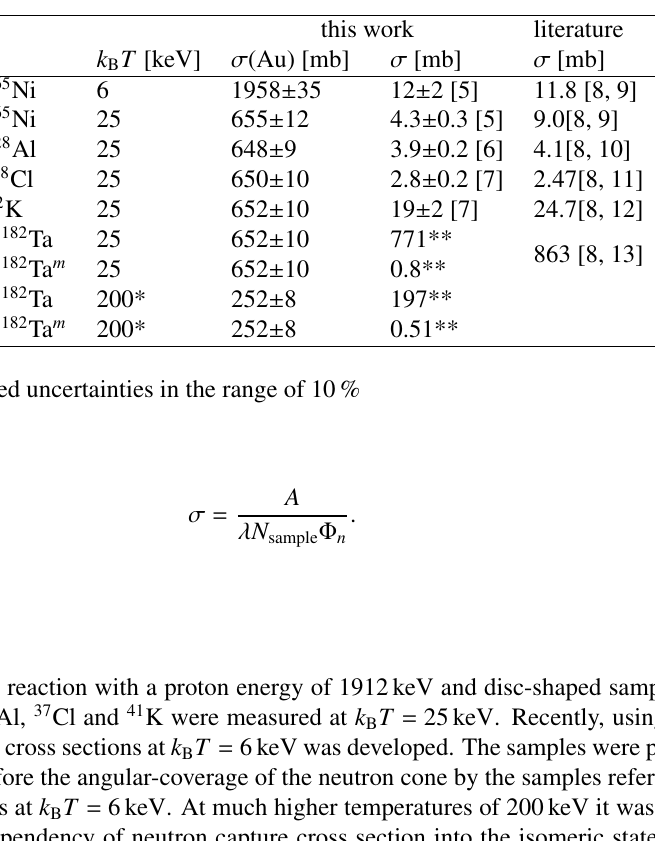
Table 1. The SACS of gold, measured and literature cross